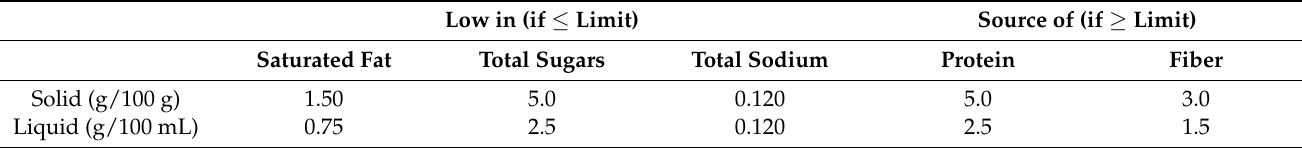
Table 1. “Low in” limits for disqualifying components and “Source of” limits for qualifying components. Low in (if ≤ Limit) Source of (if ≥ Limit) Saturated Fat Total Sugars Total